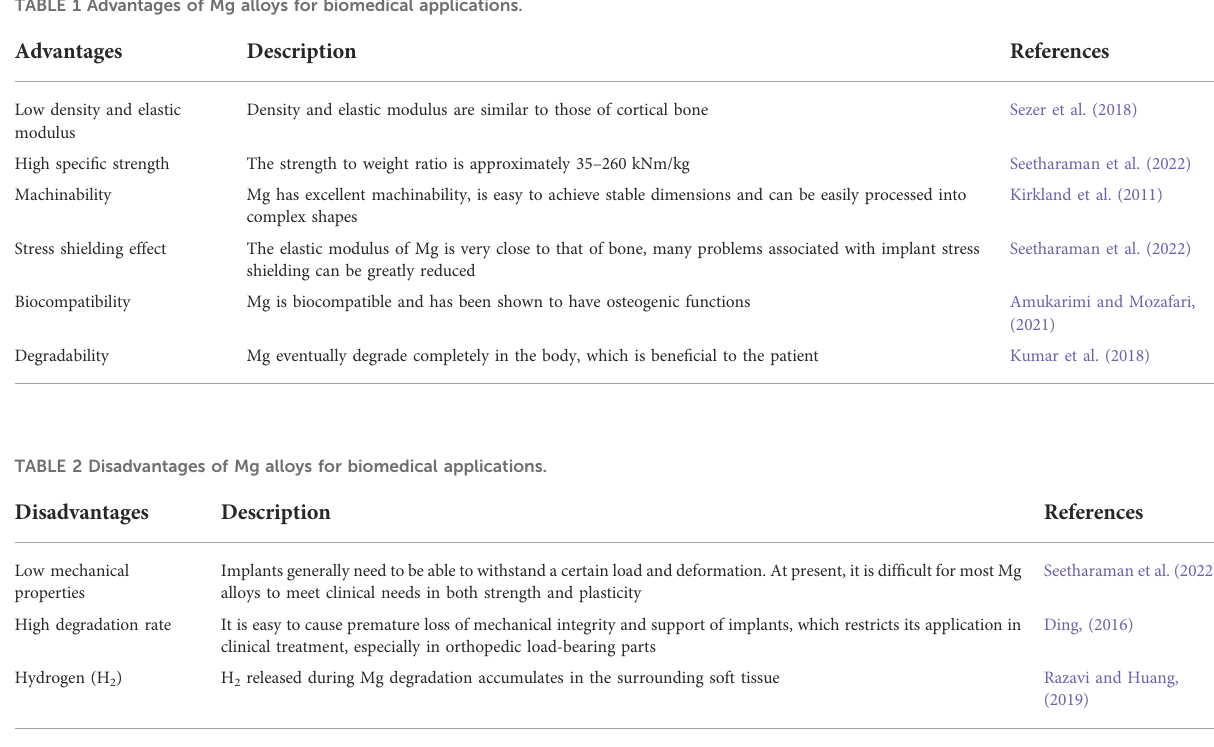
TABLE 1 Advantages of Mg alloys for biomedical applications.